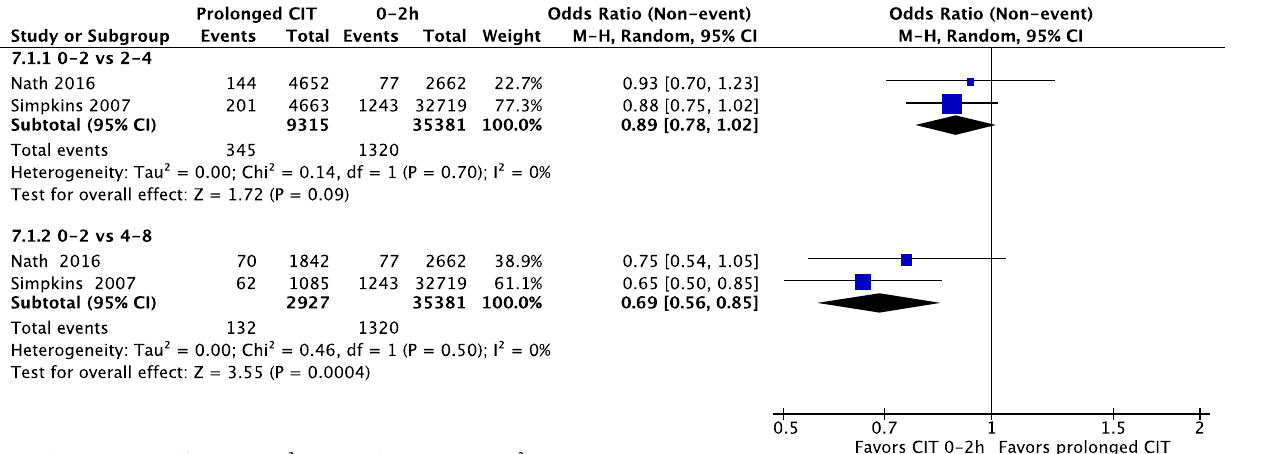
Figure 6. One-year graft survival; CIT of 0–2 h (reference) versus 2–4 and 4–8 h of CIT. CIT: cold ischaemia time.